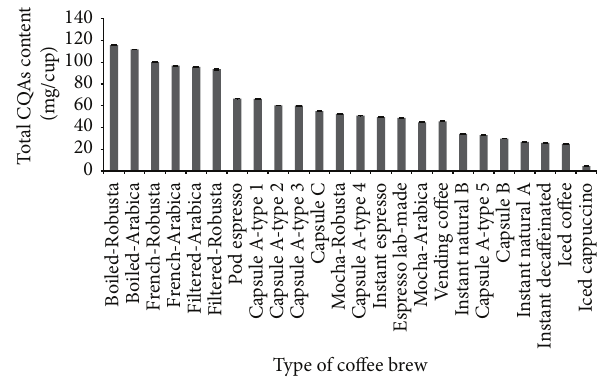
Figure 2: Total CQAs content of various types of coffee brews per cup. Cup sizes were boiled (150mL), French (150mL), mocha (60 mL), filter (150mL), capsules, pod, espresso lab-made (40mL), vending coffee (30mL), instant espresso (50mL), natural and decaffeinated instant coffees (150 mL), ice coffee (240 mL), and iced cappuccino